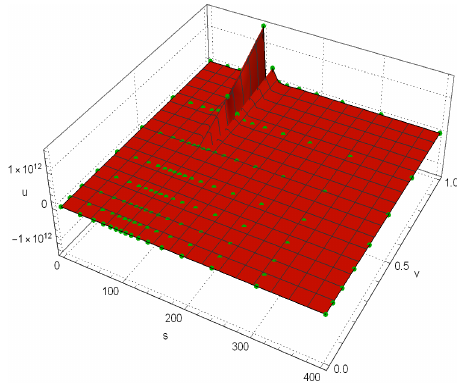
Figure 2. The instable numerical solution of Example 2 at τ = 0.5 using k = 25